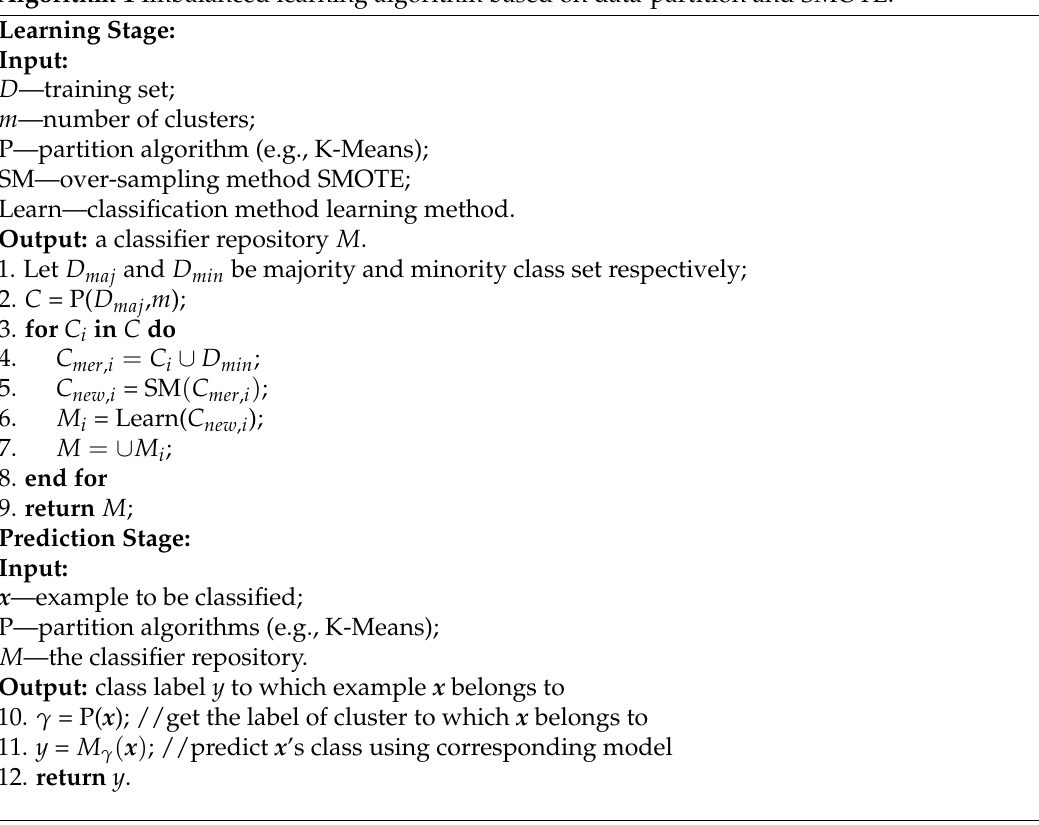
Algorithm 1 Imbalanced learning algorithm based on data-partition and